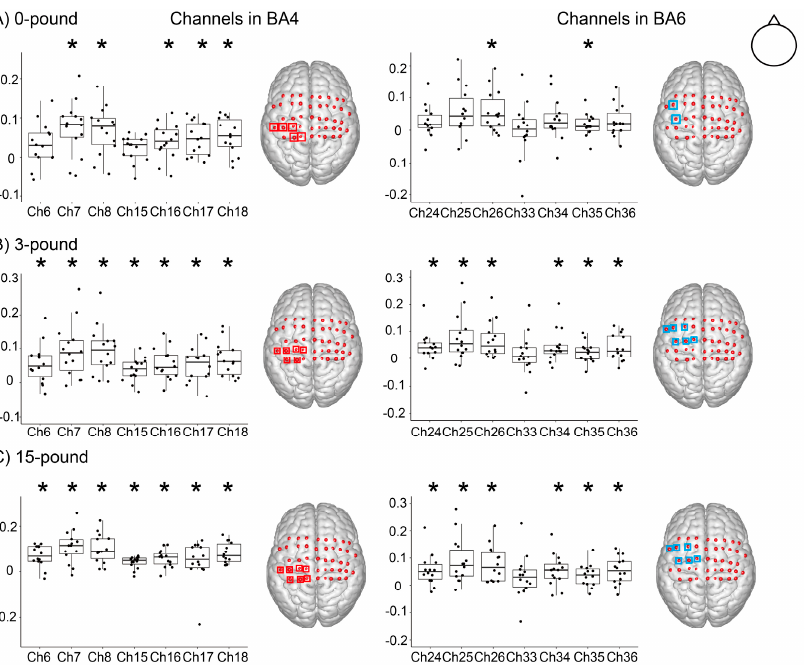
Figure 3. Channel-wise activation. Box-plot shows the median and percentile beta value of channels located in ROIs, and jitters showing the beta value of each subject. ( A ) The 0-pound condition. Five out of seven channels were activated in BA4 and two out of seven channels were activated in BA6. ( B ) The 3—pound condition. All channels in BA4 were activated, and six of seven channels were activated in BA6. ( C ) The 15—pound condition. The activated channels were the same as in the 3—pound condition but with a higher beta value. * FDR-adjusted p < 0.05 from one-sample t -test.